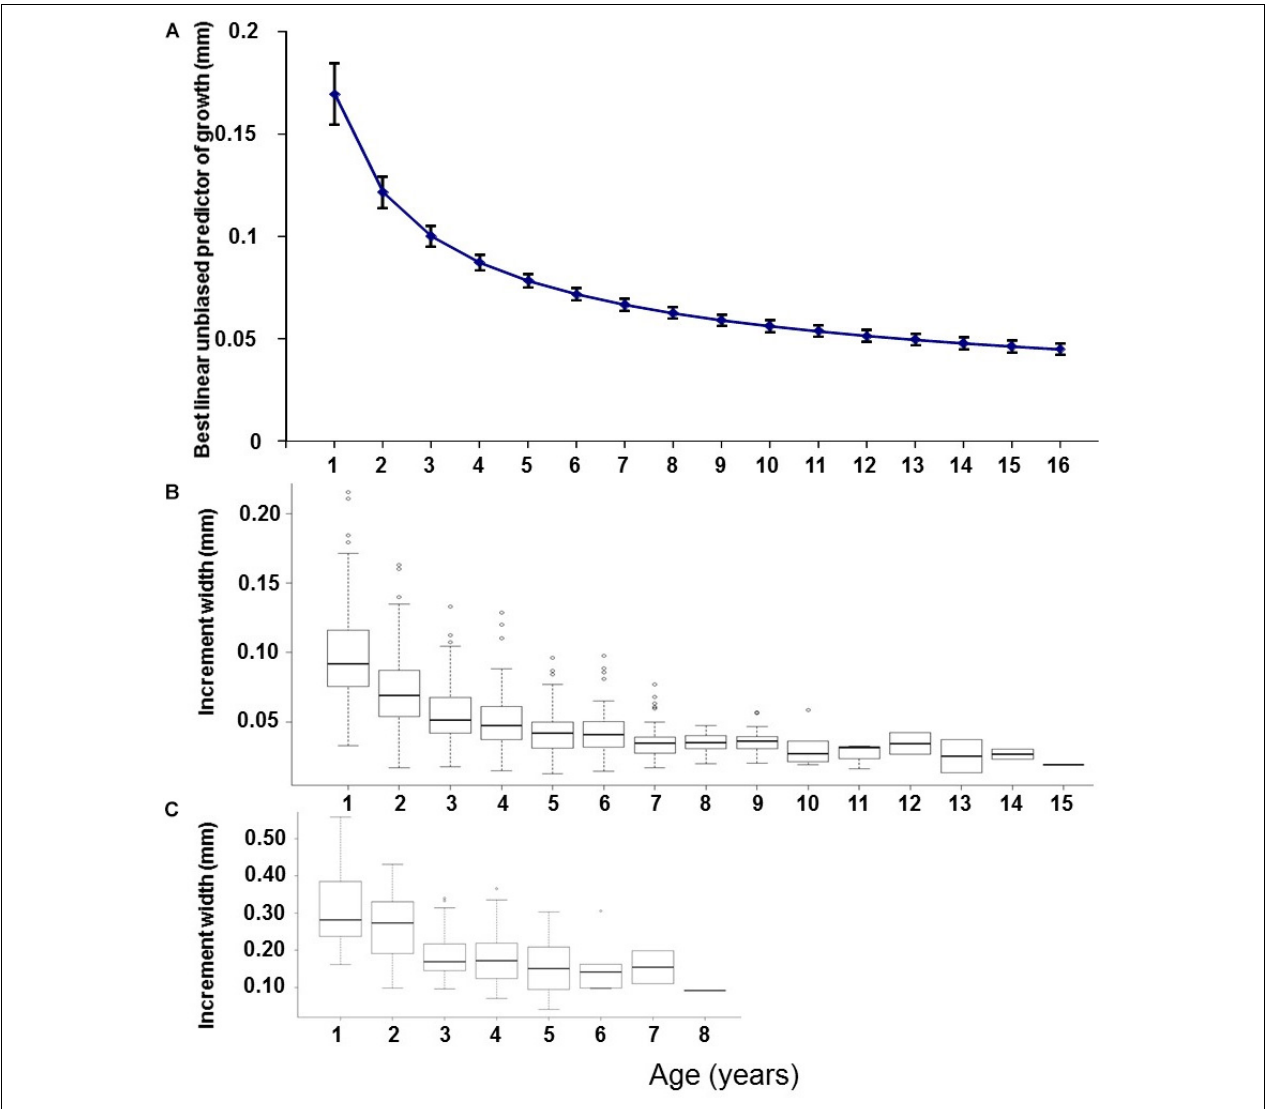
FIGURE 3 | (A) Predicted growth (mm) against age estimated in the full mixed effects model (mean age-related growth decline), back-transformed to the original scale. (B) Boxplots of absolute otolith increment width (mm) against age for the short measurement axis and (C) the long measurement axis, all for 140 otoliths of M. paradoxus caught off